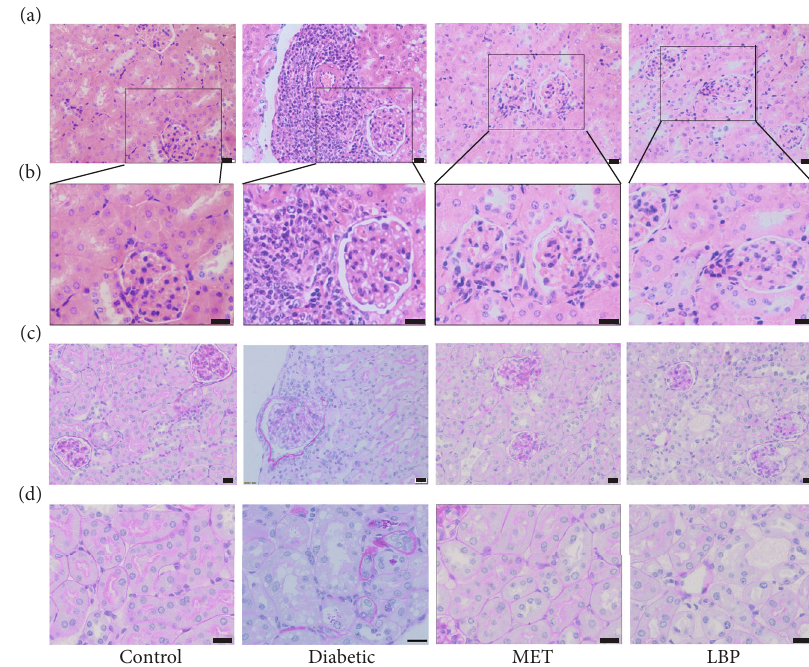
Figure 3: Histopathological changes in the kidney were analyzed through HE and PAS staining ( bar = 20 μ m, n = 6 -9 mice per group). (a) HE staining, (b) enlarged sections from (a), (c) representative sections of the thickening of glomerular basement membranes, and (d) representative sections of the tubular